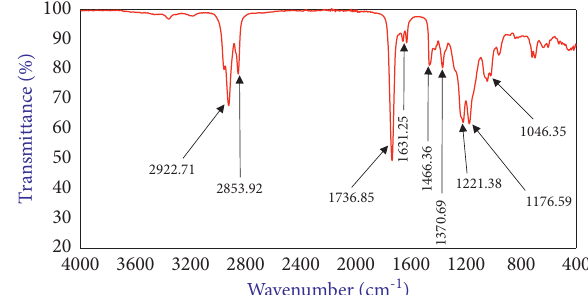
Figure 9: FTIR spectrum of fraction C from the methanol extract of V. camporum .